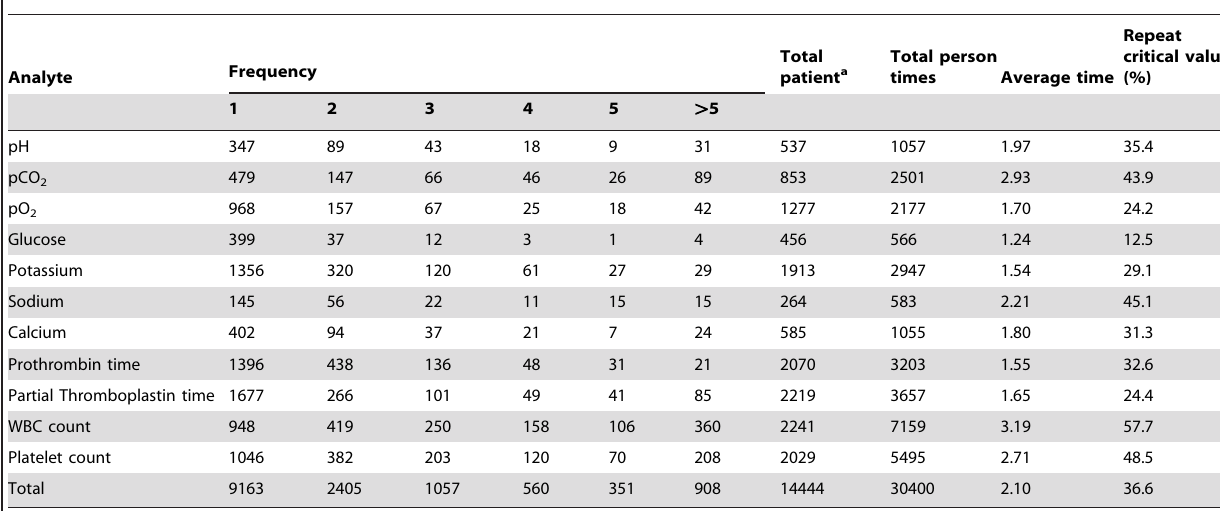
Table 2. The distribution of single analyte repeat critical values.